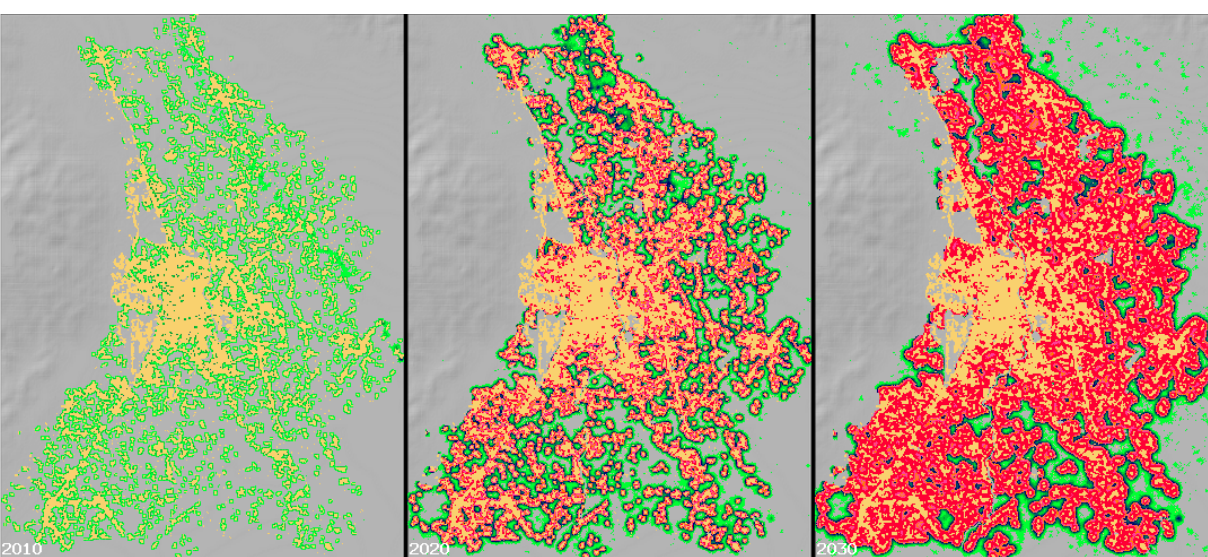
Figure 6. SLEUTH growth model was developed from cellular automaton (CA) model, which can be used for mapping urban growth and land use dynamics. Left, 2010 urbanized area, middle 2020 projection and right 2030. Without any policy shift, the model predicts 80% urbanized comprehensive planning area by 2030 (Sangawongse, Kowsuvon, & Sasom, 2011). Table 1. Land Use Change in Chiang Mai Comprehensive Plan boundary. From a paddy dominated region to one in which patches of forests, orchards, rice paddies and urban land use interact (Sangawongse et al., 2011). Area 1989 Area 2000 Area